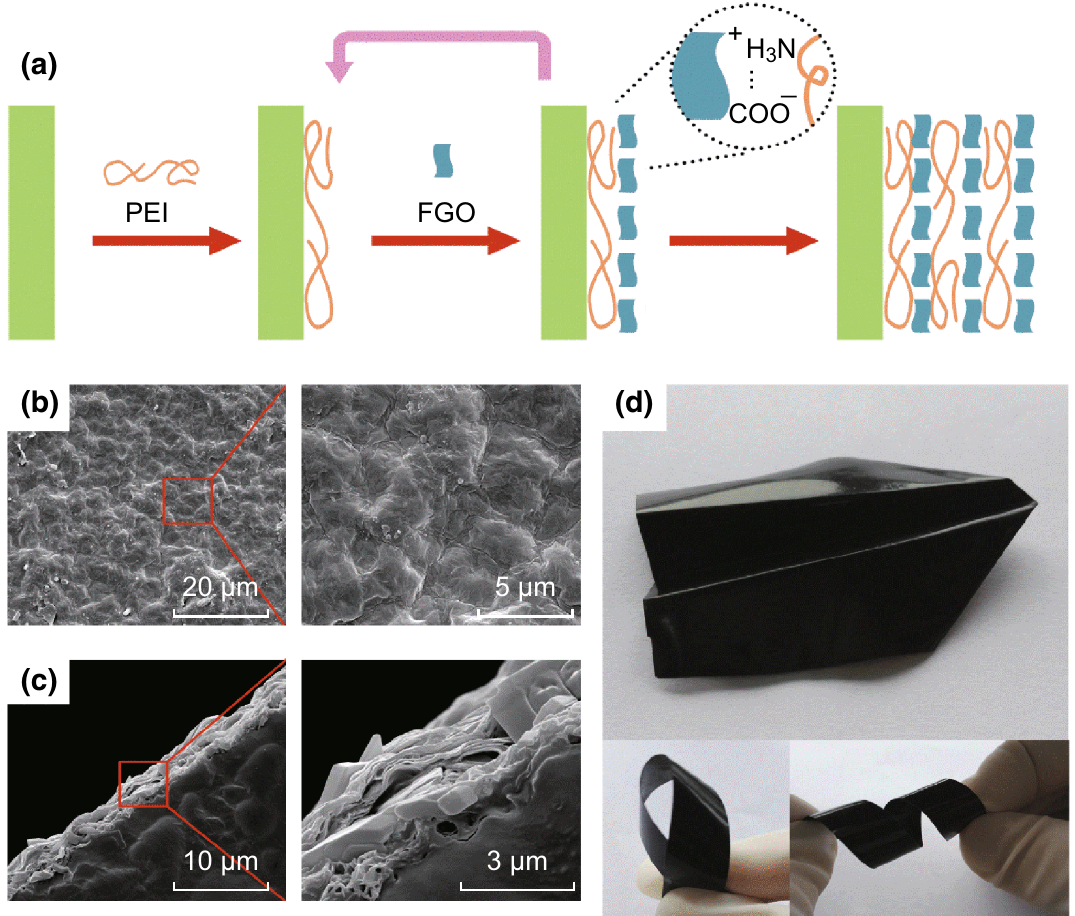
Fig. 4 a Schematic diagram of LBL assembly of FGO/PEI bilayers on PVA film. b SEM top-view images and c cross-sectional images of the coated sample. d Photographs showing excellent flexibility of the coated PVA film